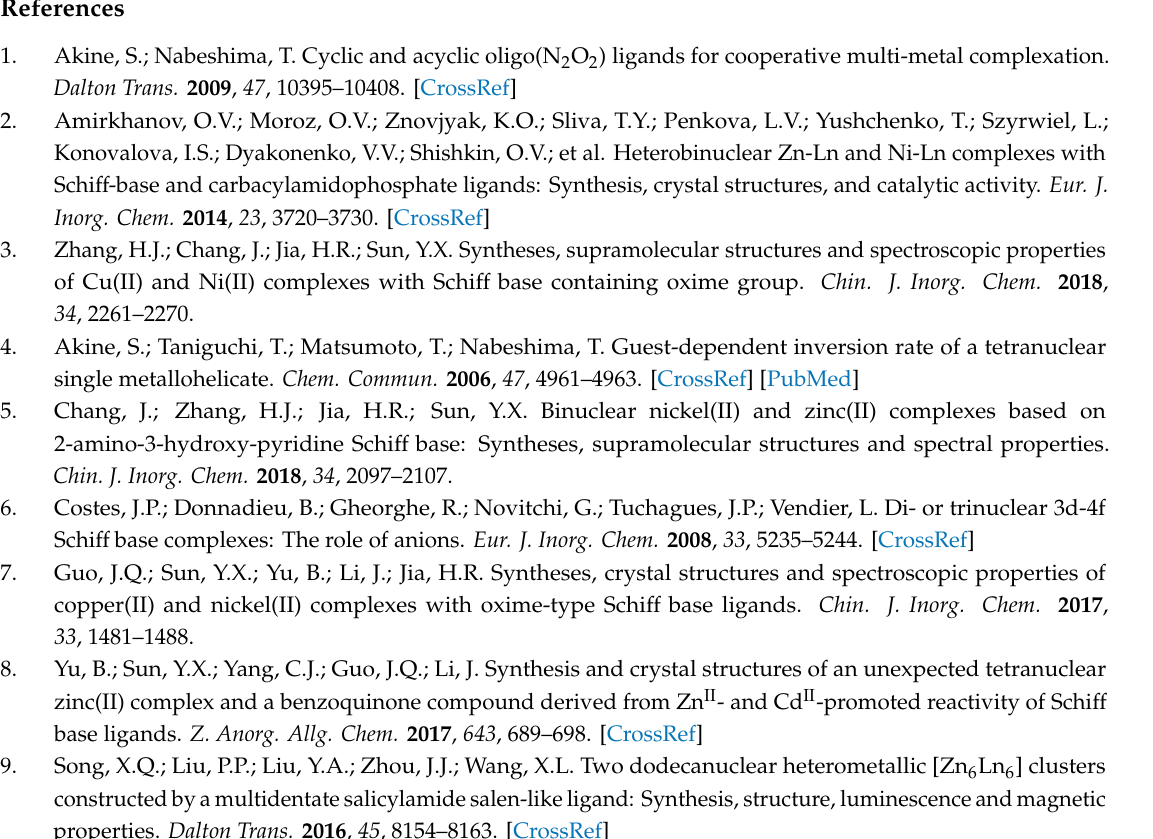
Figure S1: Infrared Spectra of H 2 L and its [Zn II 2 -Sm III 2 ] complex, Figure S2: The dihedral angle between the planes of the two pyridine rings of the [Zn II 2 -Sm III 2 ] complex, Table S1: Essential bond lengths (Å) and angles ( ◦ ) of the [Zn II 2 -Sm III 2 ]